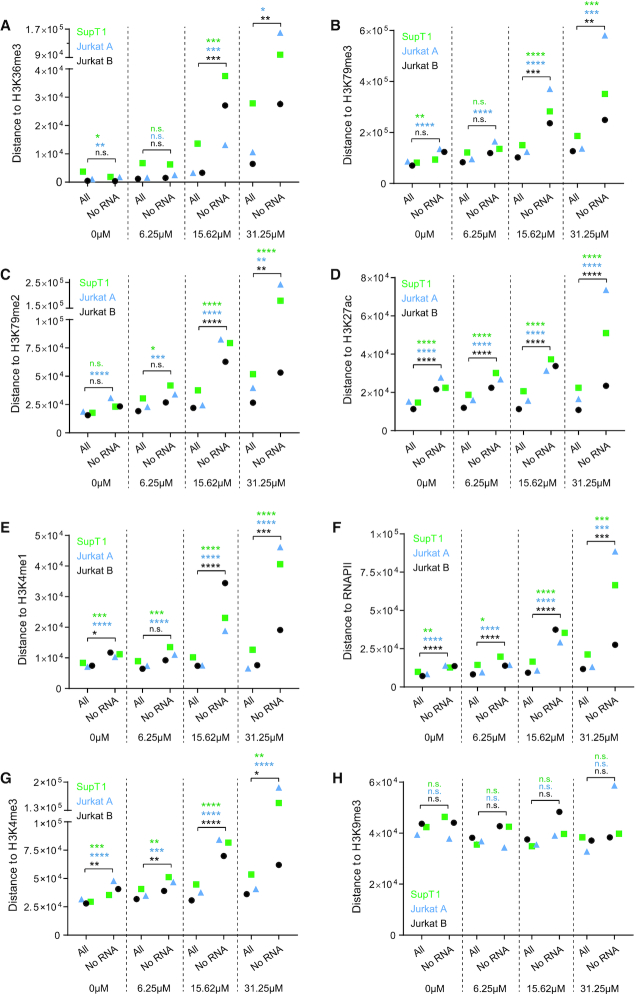
Silent barcoded provirus is targeted away from epigenetic features associated with active transcription. The distance in base pairs (bp) of integration sites to certain features was determined for either ‘all’ retrieved insertion sites or the ‘no RNA’ sites in each condition (0, 6.25, 15.62 or 31.25 μM of CX014442). The median distance (bp) is plotted on the y-axis for two independent experiments in Jurkat cells (experiment A blue, experiment B black) and one experiment in SupT1 cells (experiment A green). Panels A-H plot the distance to: (A) H3K36me3, (B) H3K79me3, (C) H3K79me2, (D) H3K27ac, (E) H3K4me1, (F) RNAPII, (G) H3K4me3 and (H) H3K9me3. Statistical significance was calculated by the Kruskal–Wallis test, * P< 0.05, ** P< 0.01, *** P< 0.001, **** P< 0.0001. bp; base pairs, RNAPII; RNA polymerase II.